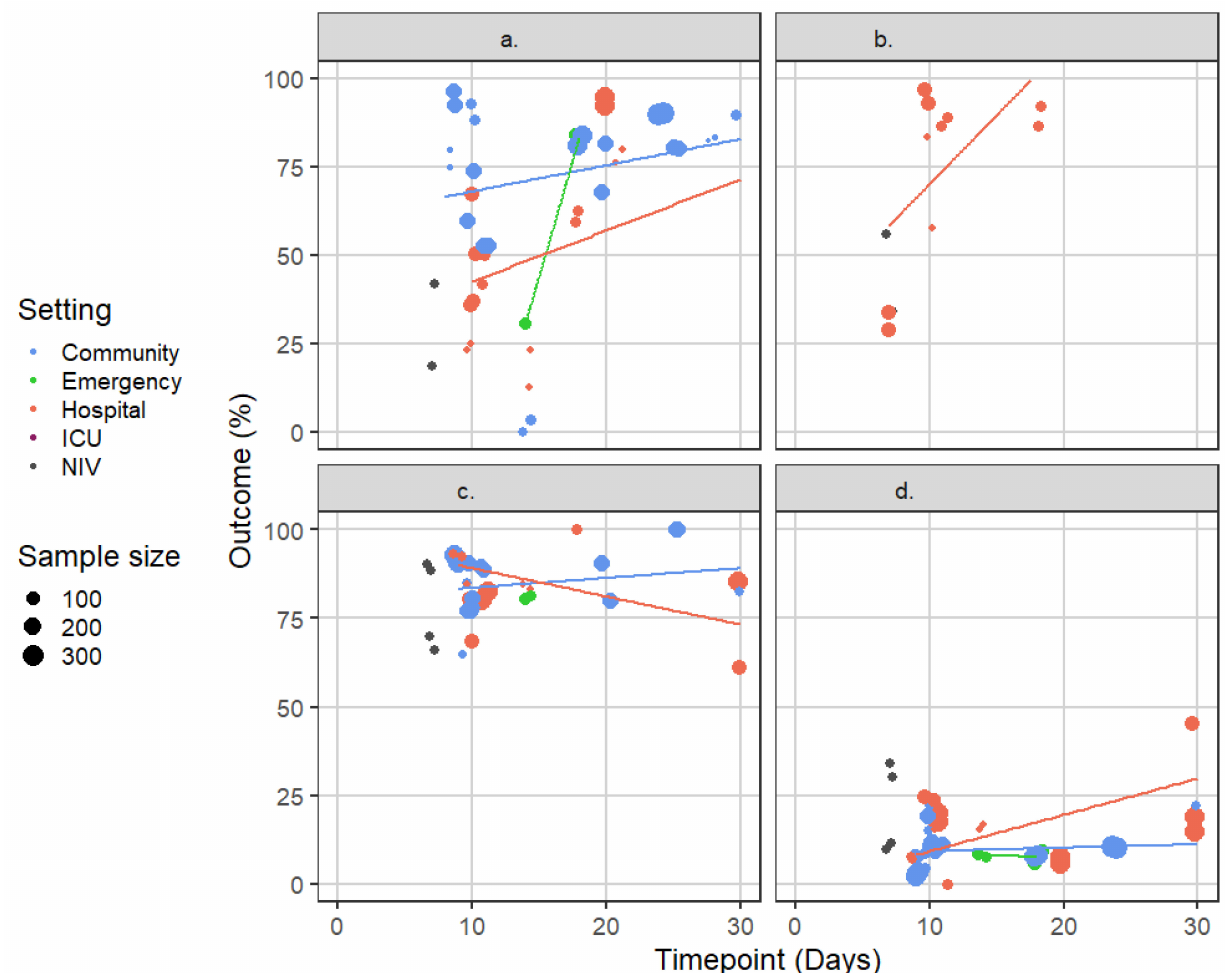
Figure 2. ( a ) Cure, ( b ) marked improvement, ( c ) improvement, or ( d ) treatment failure assessed using descriptive mea- surement instruments among participants in arms of the included trials that received treatments/interventions that are consistent with current clinical practice guidelines (i.e., study arms with experimental interventions that are not consistent with current clinical practice were excluded from this